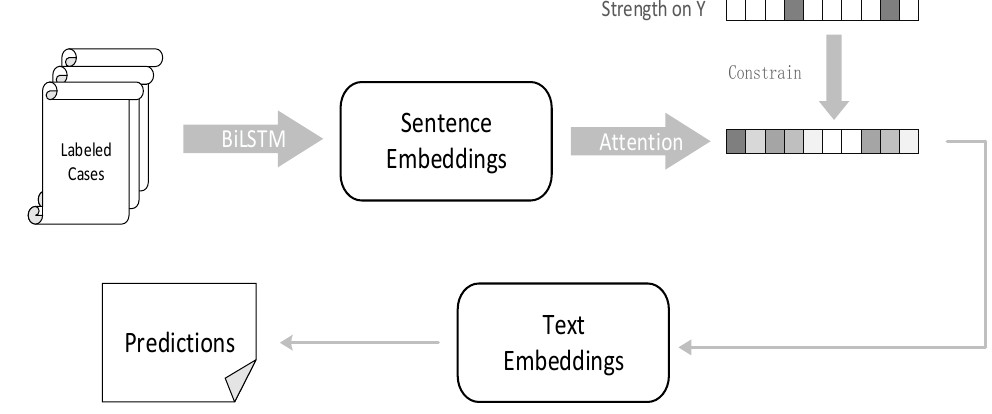
Figure 6. The use of causal strength to impose constraints.